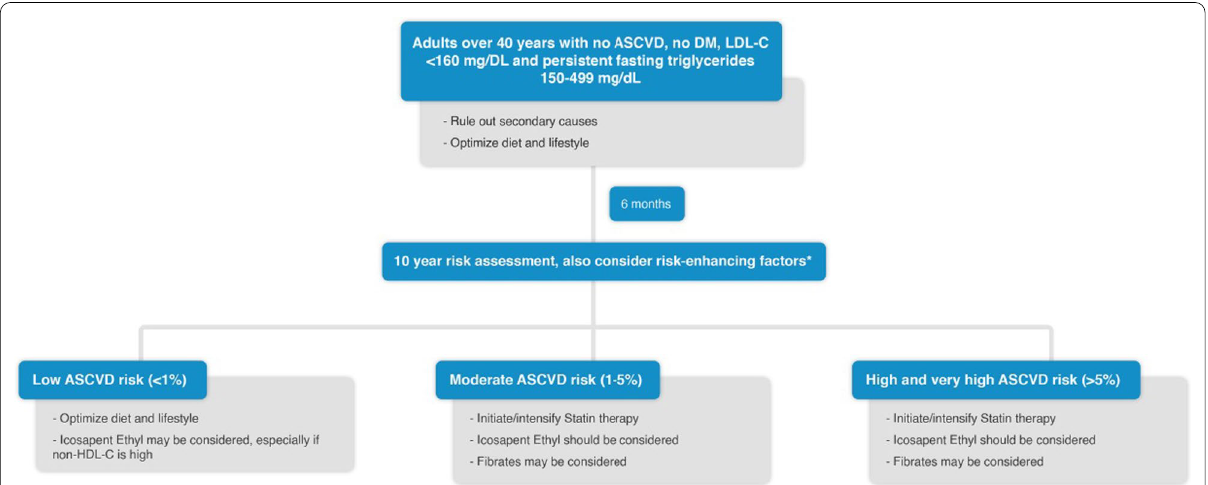
Fig. 1 Management of HTG in patients without ASCVD or DM. *ASCVD risk-enhancing factors including family history of premature ASCVD, persistently elevated LDL-C 160 mg/dL, chronic kidney disease, metabolic syndrome, inflammatory diseases (especially rheumatoid arthritis, ≥ psoriasis), biomarkers (persistently elevated fasting triglycerides 150 mg/dL, hs-CRP 2.0 mg/L) ≥ ≥